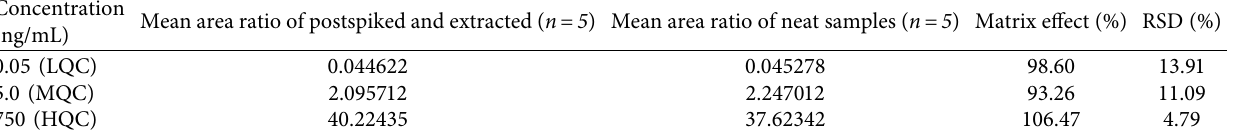
Table 3: Matrix effect of liensinine at three QC